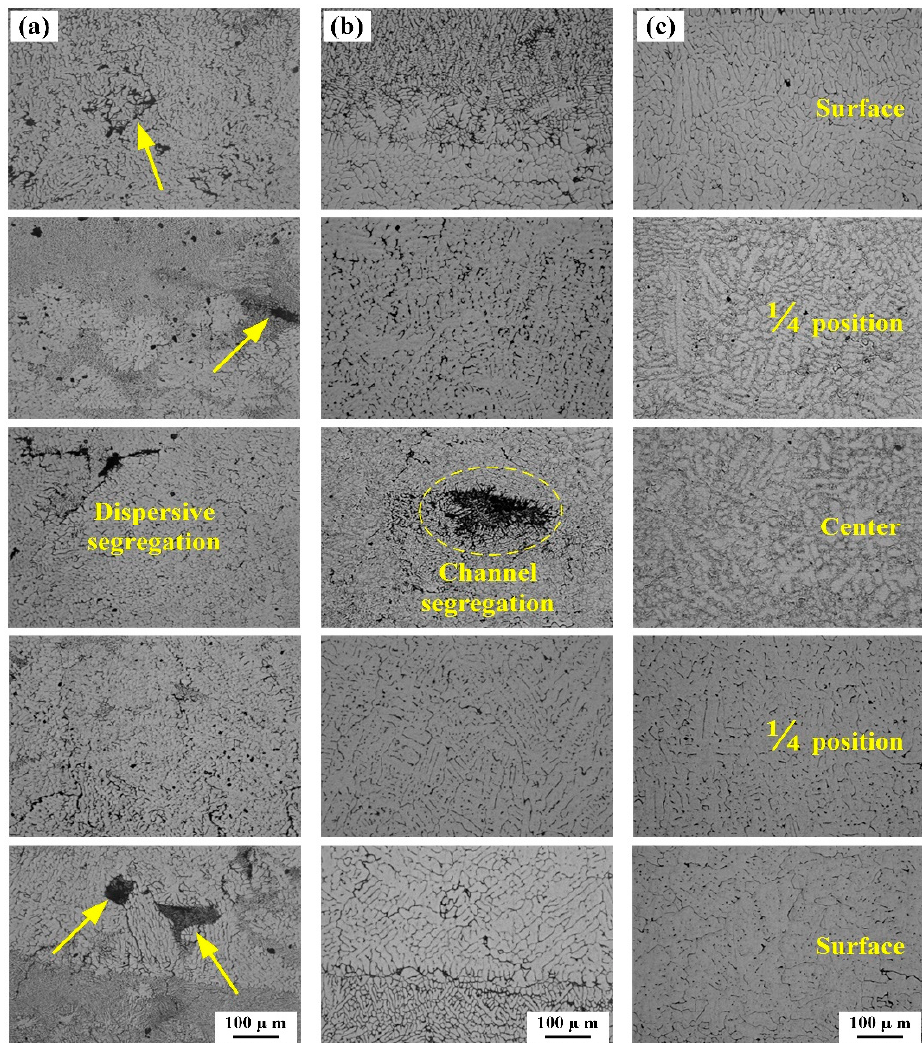
Figure 4. Microstructure of AA6022 alloy twin-roll cast strip under different processing conditions: ( a ) traditional twin-roll casting technology (TRC), ( b ) thin slab twin-roll casting technology (TS-TRC), and ( c ) Thin slab twin-roll casting with forced-cooling (FC-TRC).